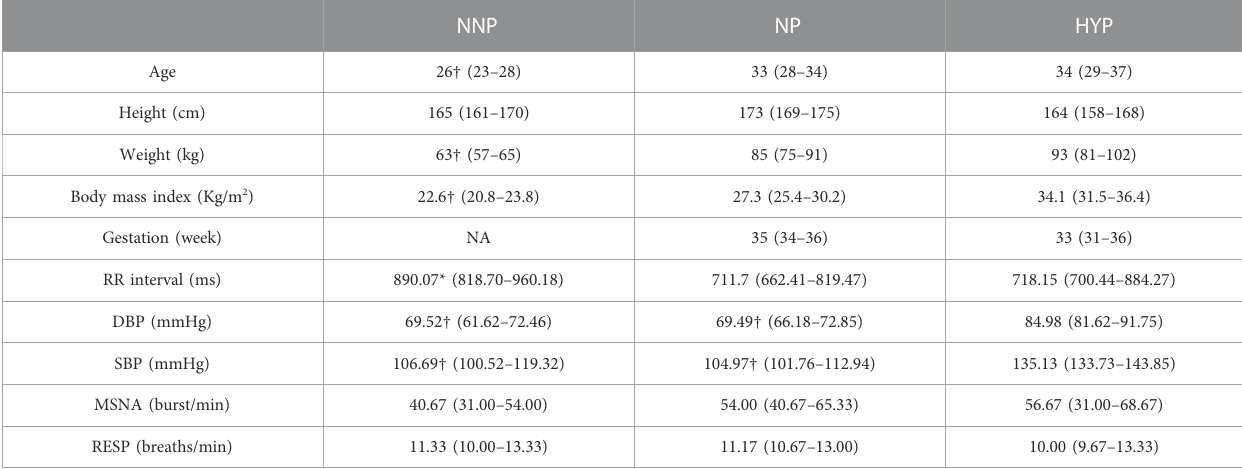
TABLE 1 Participant anthropometrics and baseline characteristics. The table shows the results for normotensive non-pregnant women (NNP), normotensive pregnant women (NP), and hypertensive pregnant women (HYP) groups in terms of median and 95% CI. RR: RR interval. DBP: Diastolic blood pressure. SBP: Systolic blood pressure. MSNA:Musclesympatheticnerveactivity.RESP:Respiratory wave.*:signi fi cantdifferencewithNP. † :signi fi cantdifference withHYP.NA: not